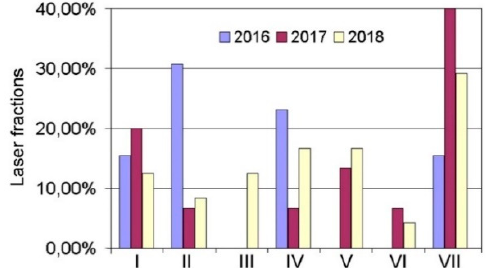
Figure 2. Frequency of use of laser types in research articles containing expert knowledge on new technologies and involving investigations into features of single tracks in laser processing (here, I—SLM machines, II—Nd:YAG lasers, III—CO 2 lasers, IV—High-power diode lasers, V—Self-development machines, VI—Hybrid lasers, VII—Fiber lasers).